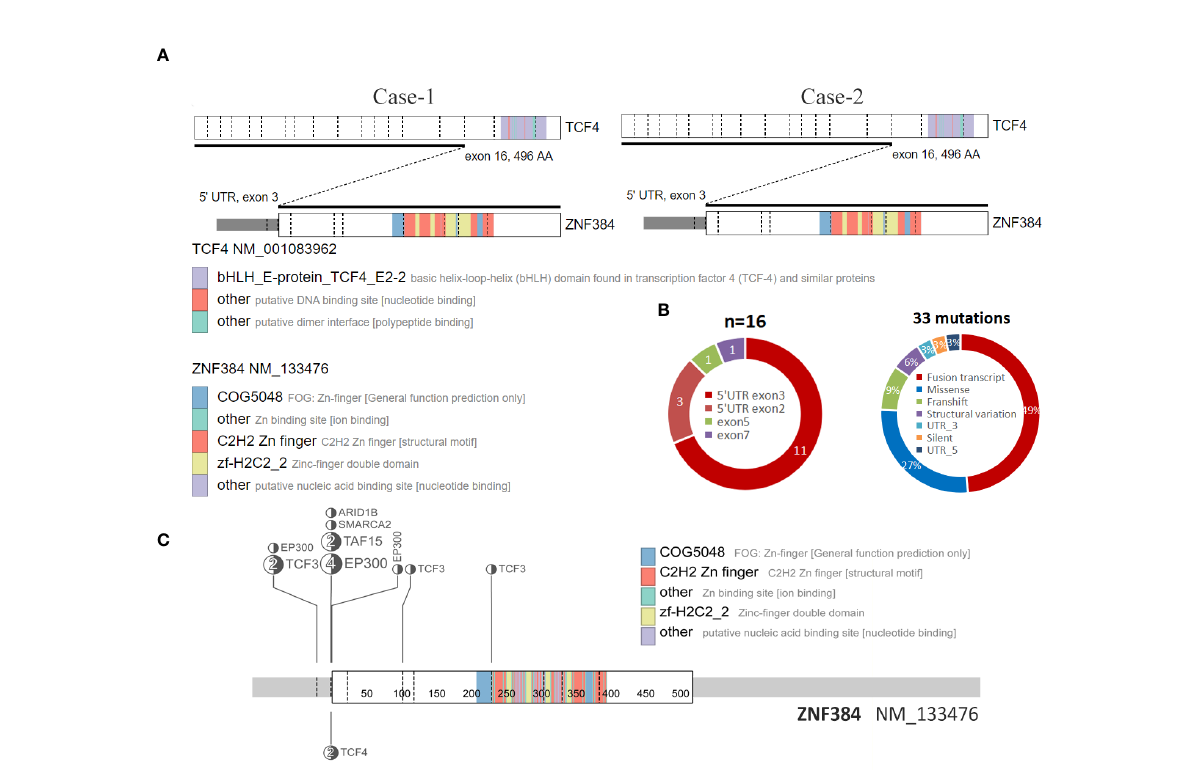
FIGURE 2 Structure of the ZNF384-related fusions. (A) The fusion of TCF4::ZNF384 and TCF4::ZNF384 chimeric protein was produced in case 1-2. Conserved protein domains (predicted by Pfam, https://pfa-m.xfam.org/) are color coded and shown in the accompanying key. Protein diagrams were generated using ProteinPaint (https://proteinpaint.stjude.org/). (B) In 33 samples with ZNF384 mutations, nearly half were ZNF384 fusion transcripts. Among these fusion partners, EP300 and TCF3 were the most common, while the fusion breakpoints of ZNF384 were mainly concentrated in the 5' UTR exon3 region, which almost retained the complete functional domain of ZNF384[5].(https:// proteinpaint.stju-de.org/). (C) Summary of all TCF4::ZNF384 fusion cases described to